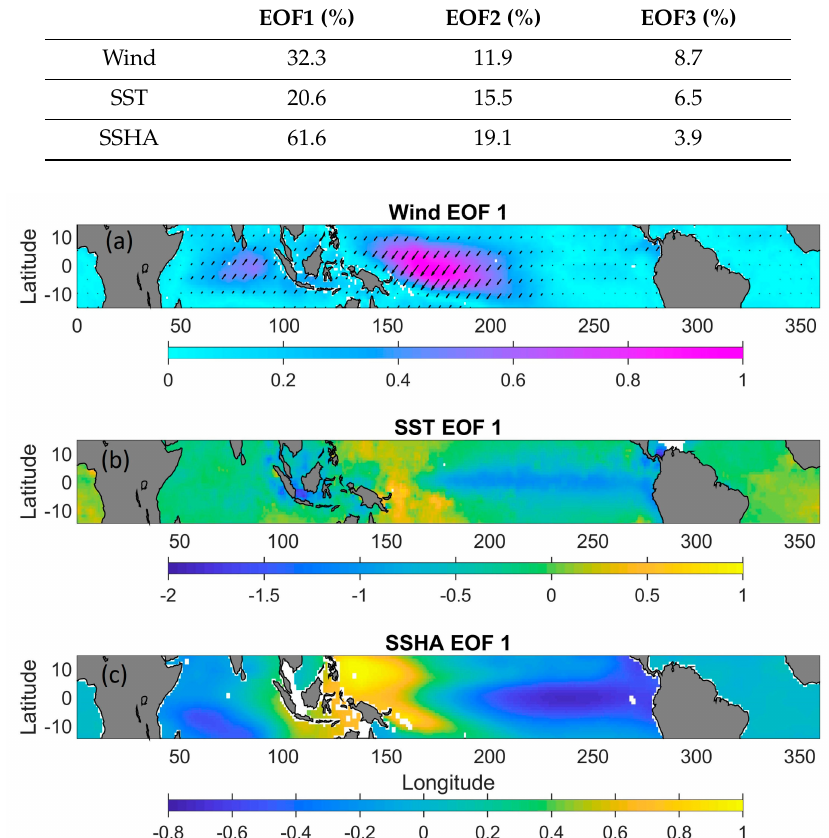
Figure 1. The first spatial empirical orthogonal function (EOF) mode of wind vector ( a ), sea surface temperature (SST) ( b ), and sea surface height anomaly (SSHA) ( c ). These spatial EOF mode values were normalized by their respective